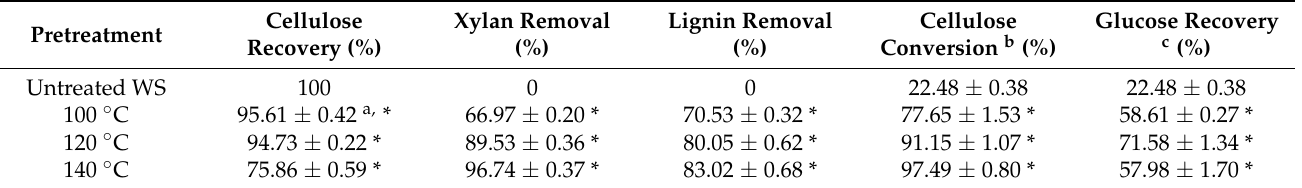
Table 2. Effects of different pretreatment temperatures on recovery, removal, and enzymatic hydroly- sis of